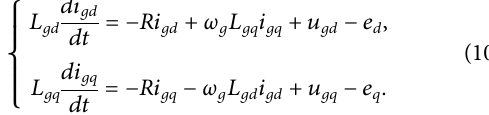
Frontiers in Energy Research |